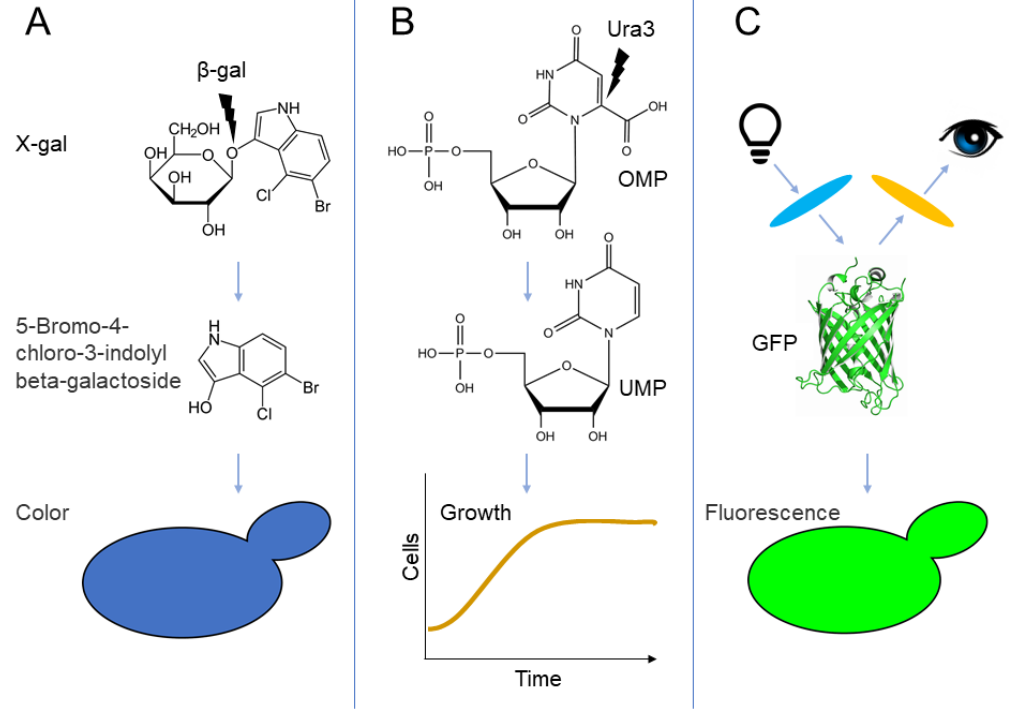
Figure 1. Reporter systems for degron discovery. ( A ) β -gal hydrolyzes X-gal to produce 5-bromo-4-chloro-3-indolyl β -galactoside is detected by formation of dark blue-colored yeast colonies. ( B ) Orotidine-5 ′ -phosphate decarboxylase (Ura3) catalyzes the decarboxylation of OMP, converting it into UMP, an intermediate of pyrimidine biosynthesis. Ura3 activity is essential for growth of uracil auxotroph yeast. ( C ) Excitation of green fluorescent protein (GFP) causes the emission of fluorescence signal, visualized by fluorescence microscopy. OMP: orotidine 5′ -monophosphate; UMP: uridine 5 ′ -monophosphate.